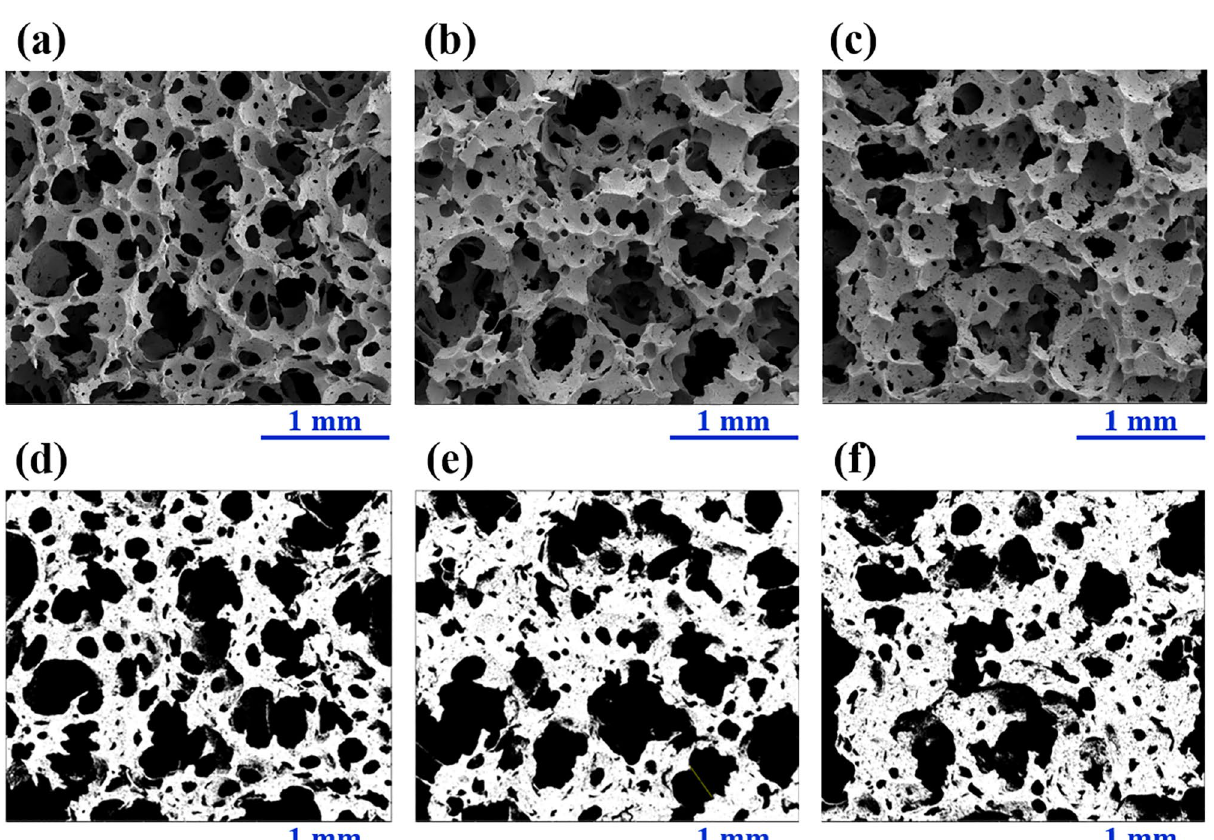
Figure 2. SEM images of the various foam samples at 50× magnification: ( a ) control − 10% NR, ( b ) control, and ( c ) control + 10% NR. Images of various foam samples from ImageJ analysis: ( d ) control − 10% NR, ( e ) control, and ( f ) control + 10% NR. The white areas are related to the interconnected foam, whereas the black areas relate to the pore or